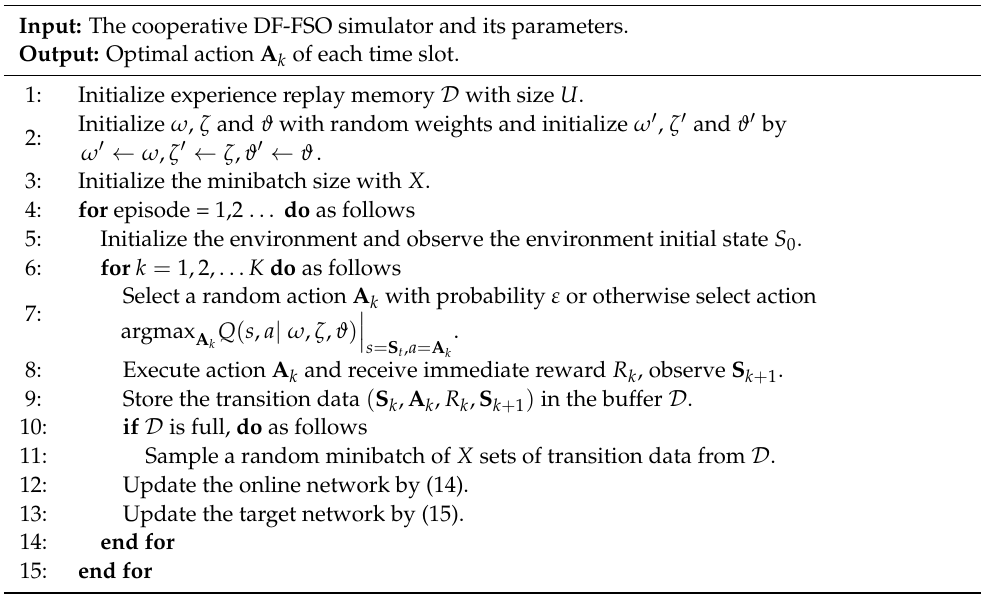
Algorithm 1. The pseudocode diagram of the proposed DQN-RS algorithm.